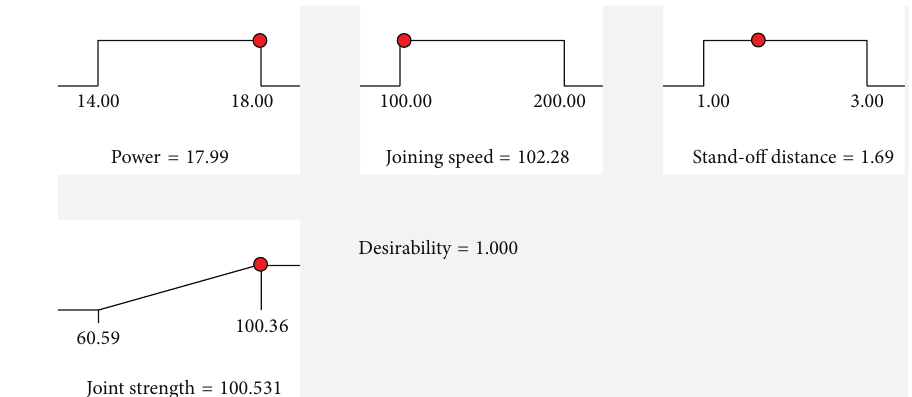
Figure 6: Ramp function graph for maximum joint strength with desirability one.